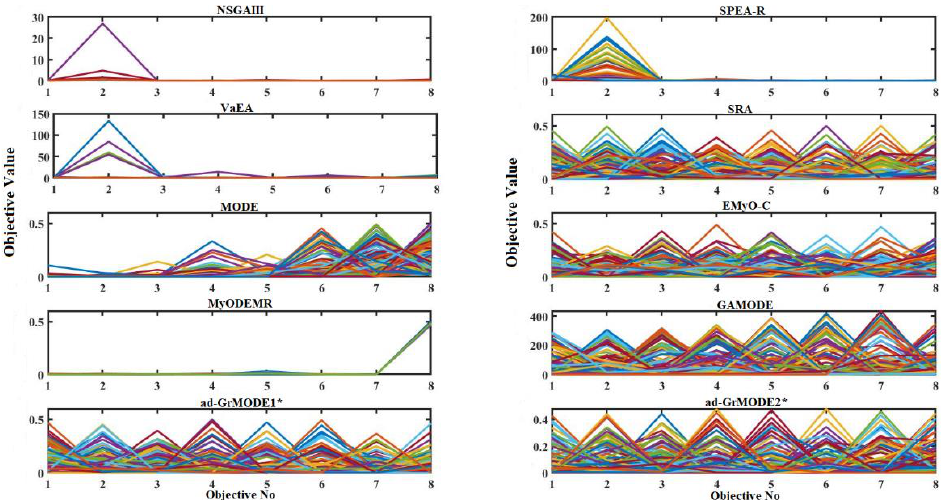
Figure 3. Wilcoxon signed-rank tests at a 5% significance level with respect to the HV for the DTLZ and WFG problems using ad-GrMODE and state-of-the-art algorithms: ( a ) ad-GrMODE1* com- pared with state-of-the-art algorithms; ( b ) ad-GrMODE2* compared with state-of-the-art algo- rithms.